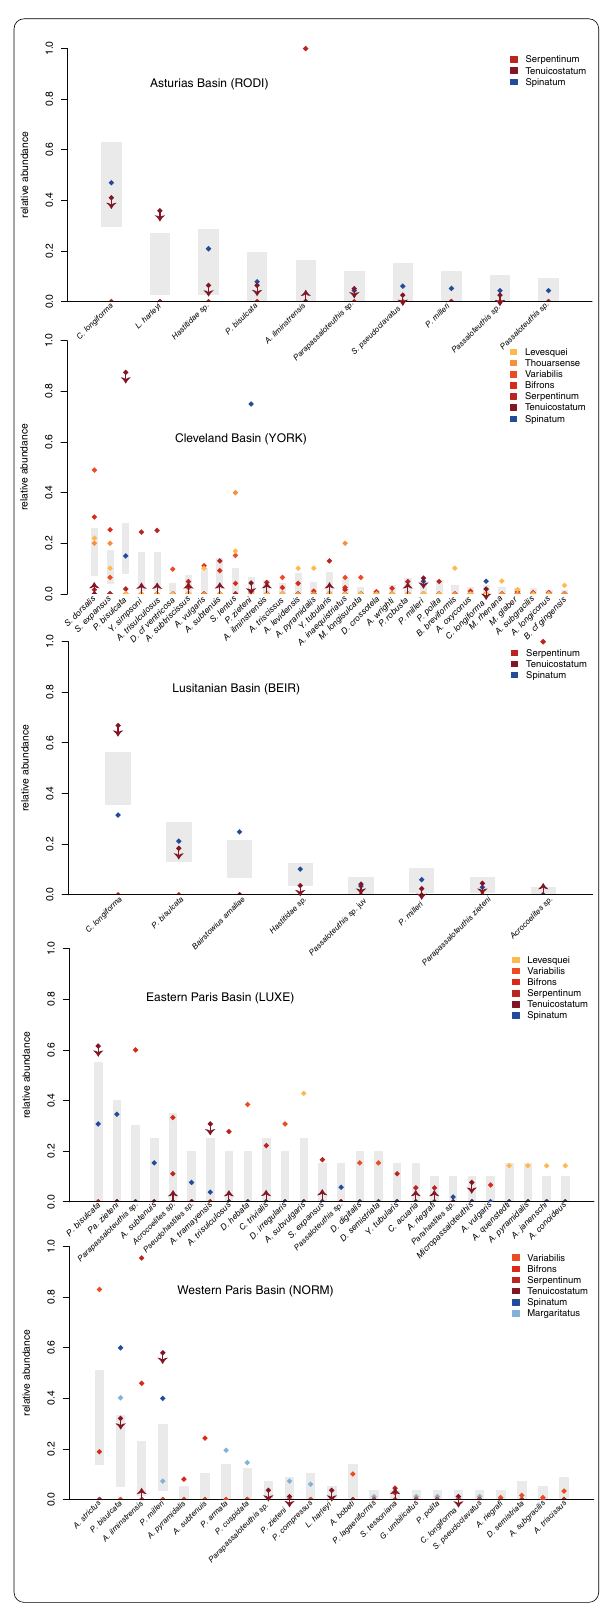
Fig. 5 Results of the Bootstrap method for various basins. Only points corresponding to zones falling outside the grey boxes reflect significant changes in relative abundance of species. Arrows highlight in which direction to look for the relative abundance calculations when going from the Tenuicostatum (post‑Pli‑Toa) to the Falciferum Zone (post‑TOAE). An enlarged version can be found in the supplementary material (Fig. S9)